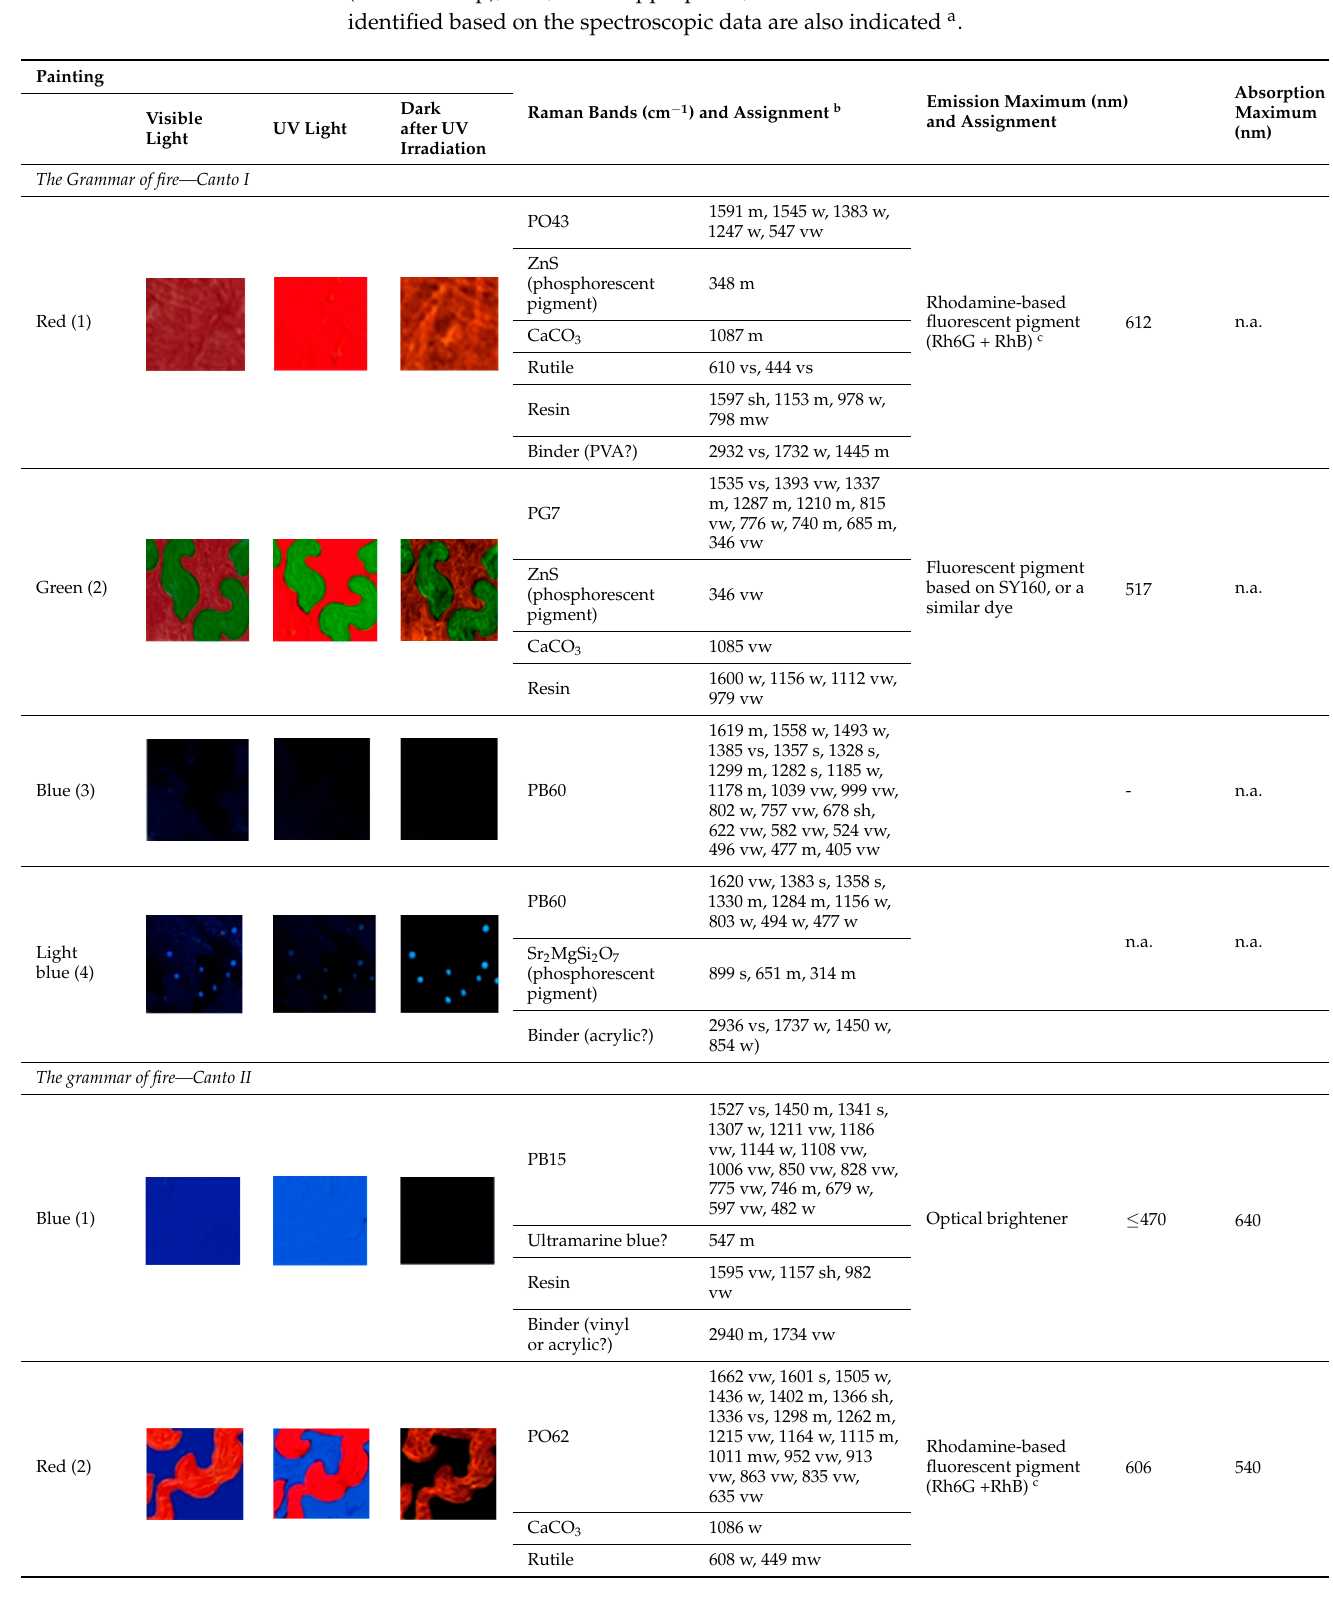
6 of 20 Table 2. Measurement areas of the four paintings examined at the Black Light Art exhibition. For each area, the color, the wavenumbers of the Raman bands, and the wavelengths of the emission and visible absorption maxima are reported. For each color, the appearance in visible light, UV light (Wood’s lamp), and, when appropriate, in the dark after UV irradiation is shown. The materials identified based on the spectroscopic data are also indicated. a